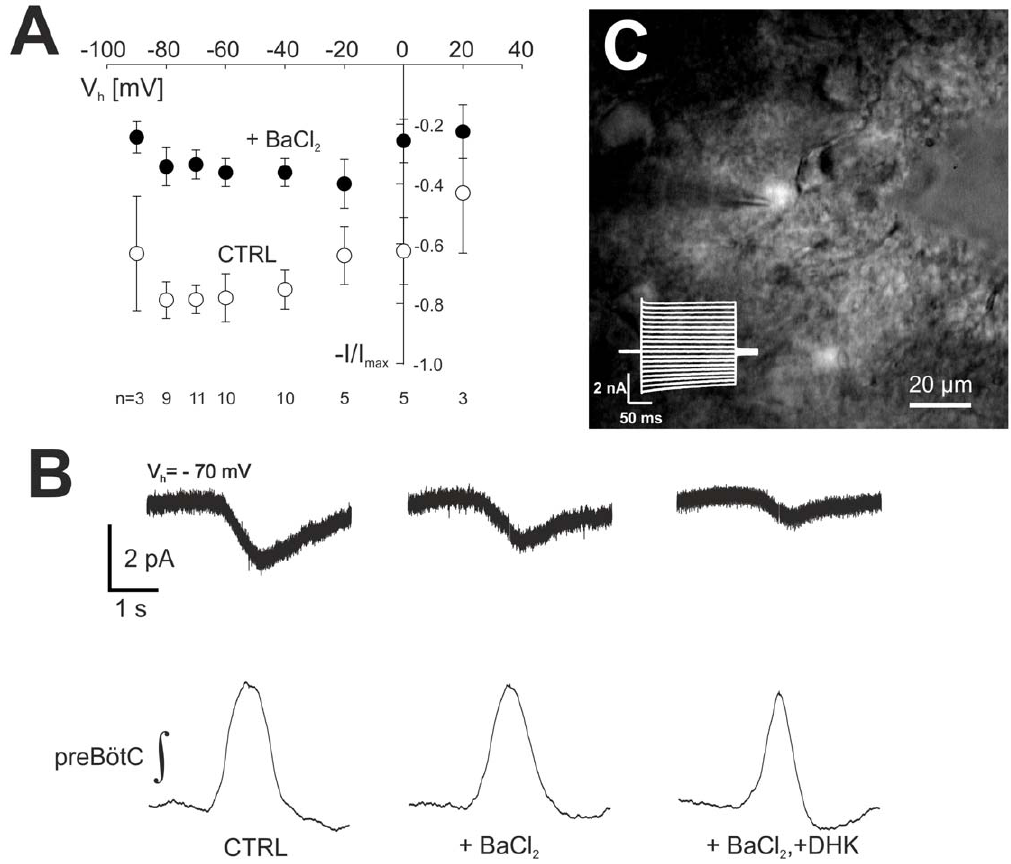
Figure 2. Analysis of respiratory-rhythmic astrocytic currents (I resp,A ). In panel ( A ) the effect of BaCl 2 on I resp,A is shown. Data, for each cell normalized (I/I max ) to the largest current measured over the range of holding potentials, are given for the different holding potentials from 2 90 mV to + 20 mV. Error bars indicate mean 6 SEM. The number of cells is indicated below each set of data points. Panel ( B ) shows cycle-averaged currents (holding potential 2 70 mV) that were recorded from the rhythmic astrocyte ( C ) under control conditions, in the presence of barium (BaCl 2 , 100 m M) and after additional inhibition of glutamate uptake by dihydrokainate (DHK, 300 m M). The cycle-averaged traces of the corresponding integrated preBo¨tC field potential are depicted underneath.